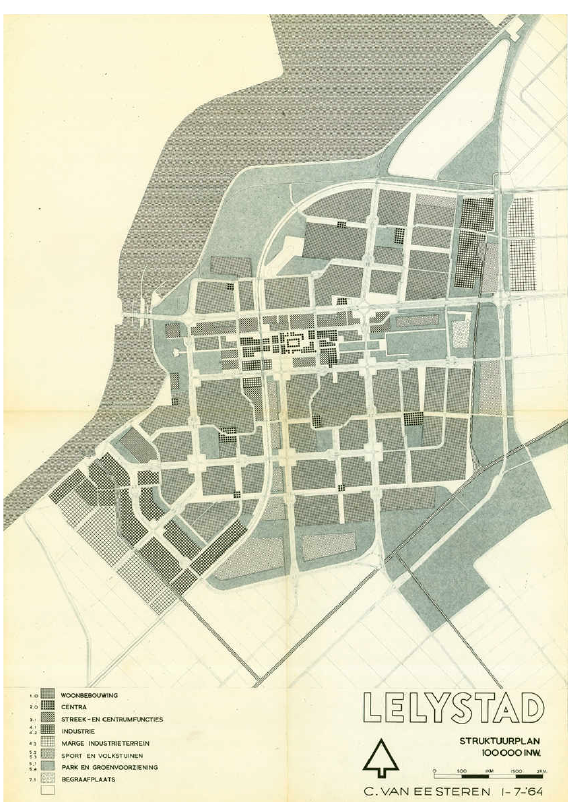
Figure 4. Van Eesteren’s structure plan, July 1964. Source: Flevolands